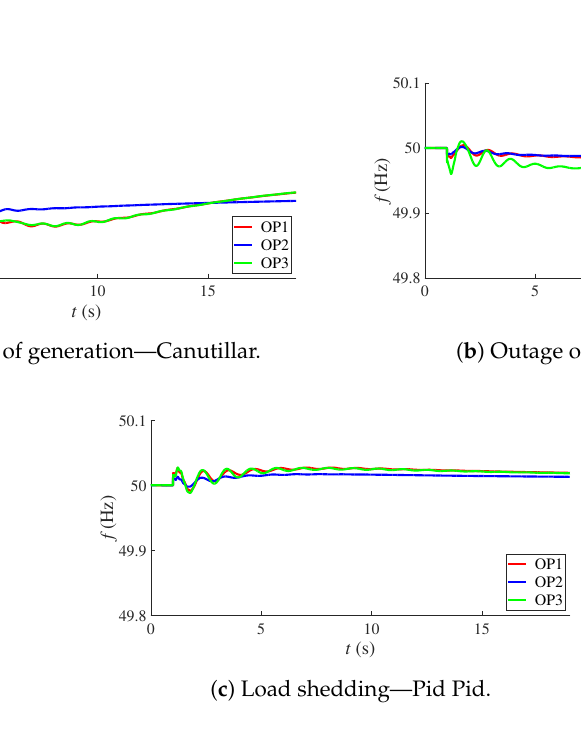
Figure 16. Frequency of the network. Table 7. Characteristics of the outages/shedding in (MW).